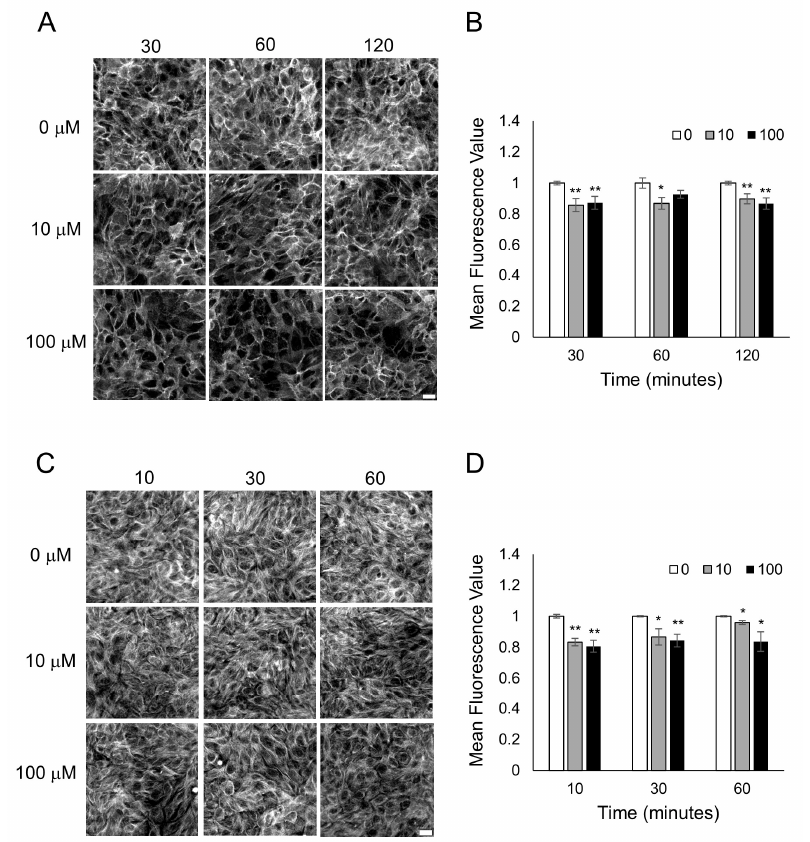
Figure 5. Sandalore exposure causes F-actin and microtubule disassembly in HaCaT cells. Fluorescent images of F-actin phalloidin staining ( A ) and tubulin staining ( C ) after HaCaT cells were treated with 0, 10, 100 µ M Sandalore for 10–120 min. Scale bar = 20 µ m. Quantitative mean fluorescence intensity of F-actin staining ( B ) and tubulin staining ( D ) was measured using Fiji. A two-tailed t -test was performed to compare each lyral-treated group to the control group completed at the same time point; ** p < 0.01 and * p < 0.05 as